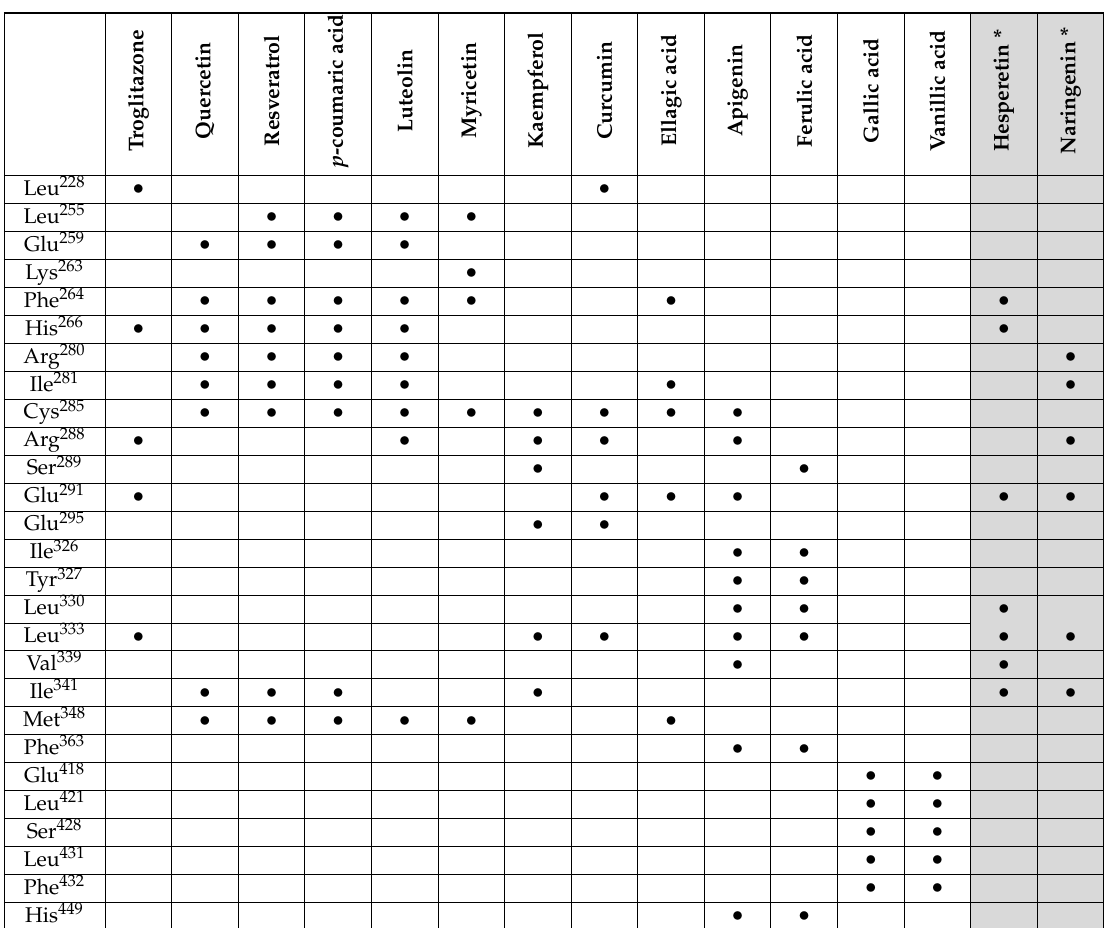
Table 2. Common amino acids of the ligand-binding domain (LBD) of PPAR γ implicated in the interactions with the different phenolic compounds, indicated by black dots ( •